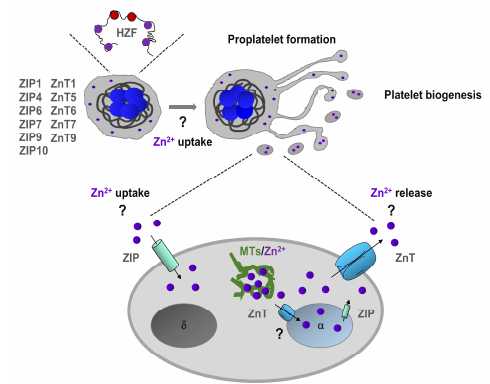
Figure 1. Zn 2 + homeostasis in megakaryopoiesis and platelet biogenesis. Megakaryocytes express Zn 2 + -finger gene (Hzf), which regulates platelet formation and α -granule biogenesis. In addition,